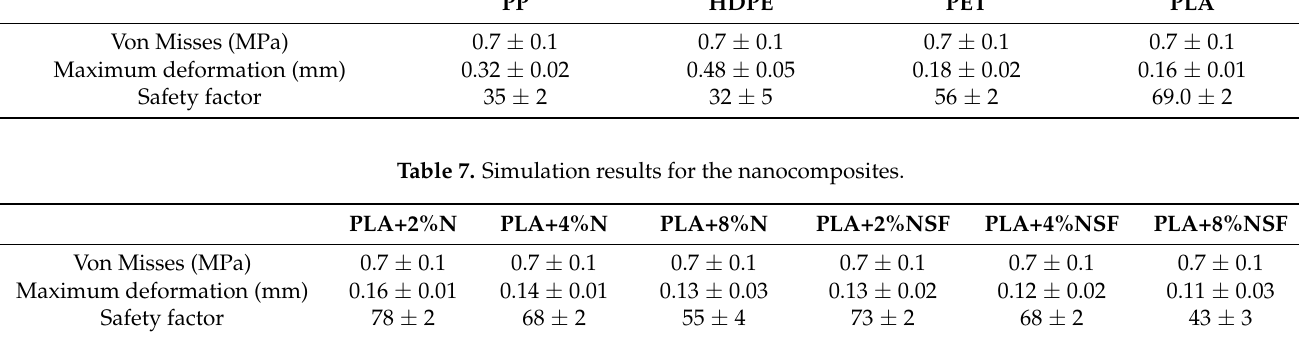
Table 7. Simulation results for the nanocomposites.